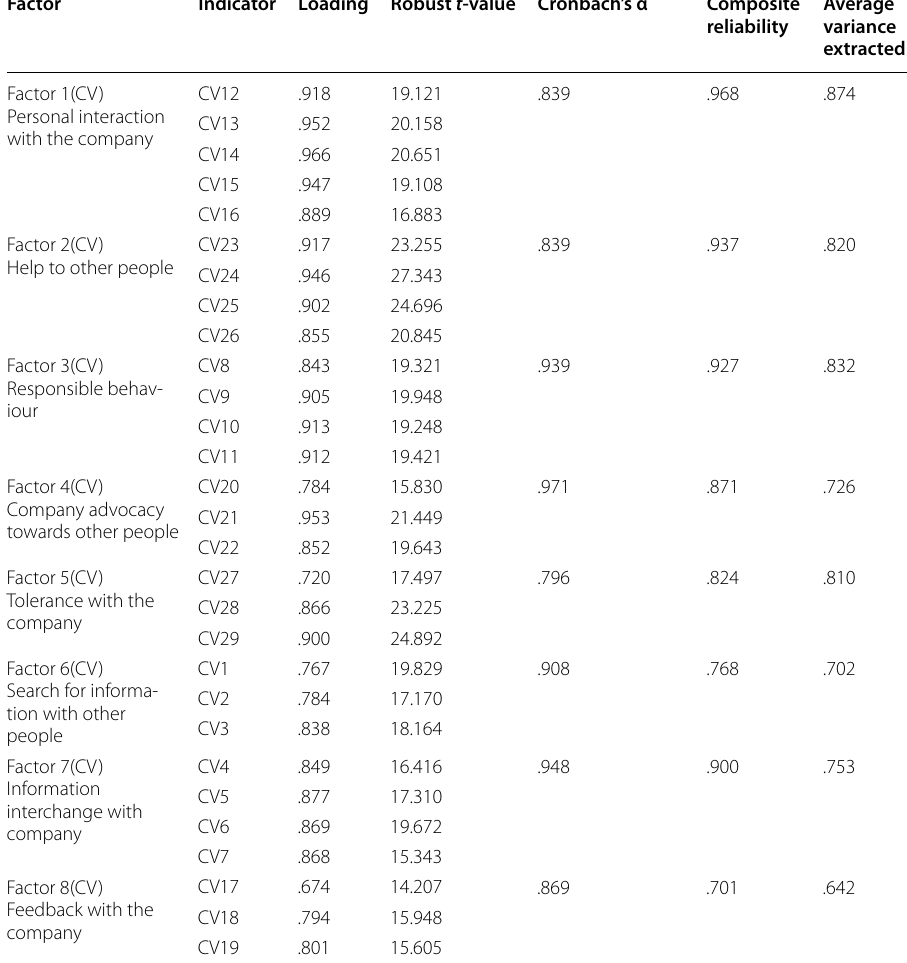
Table 4 Internal consistency and convergent validity: co‑creation